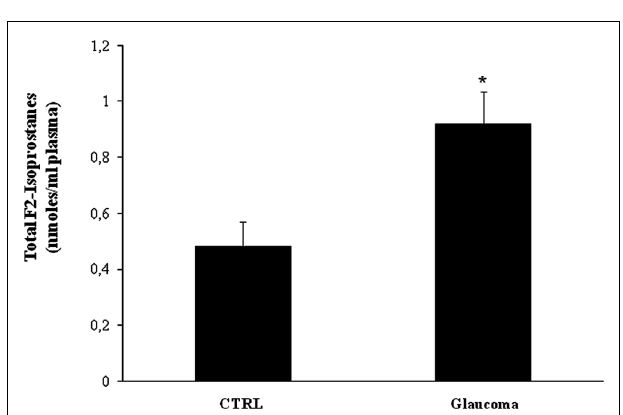
FIGURE 9 |Total F2-isoprostanes levels in plasma glaucoma patients. Plasma samples from patients with glaucoma and age-matched controls were assayed for total F2-isoprostanes. Data are expressed as mean ± SEM of 18 to 20 patients per group. * P < 0.05 vs. controls.